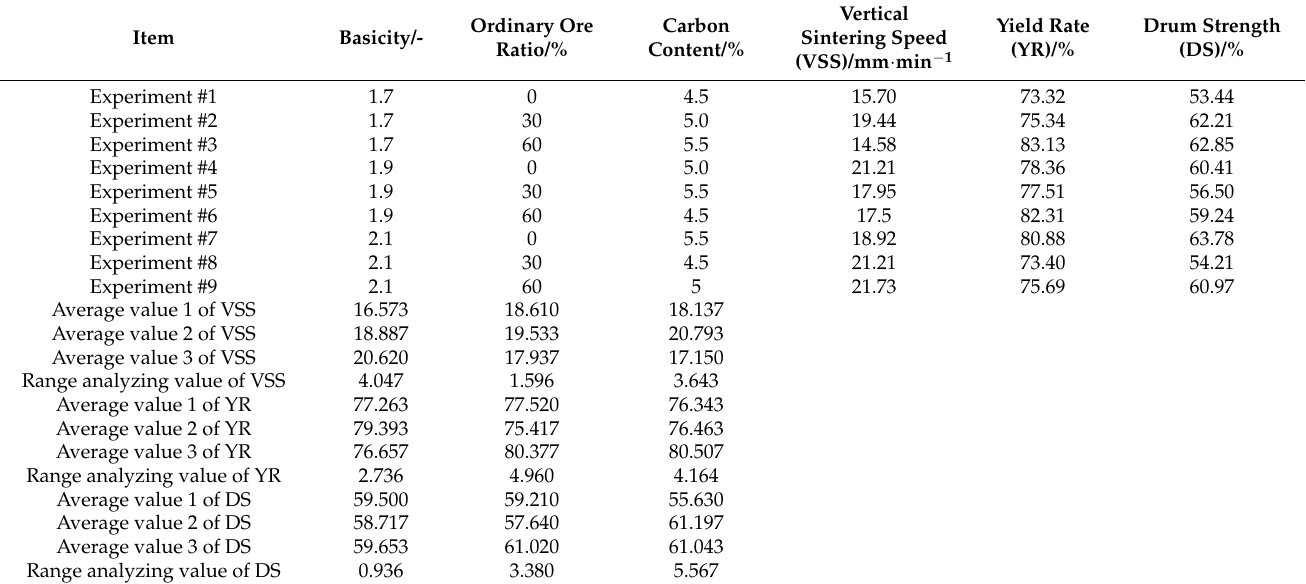
Table 8. Experimental results of cold metallurgical properties and range